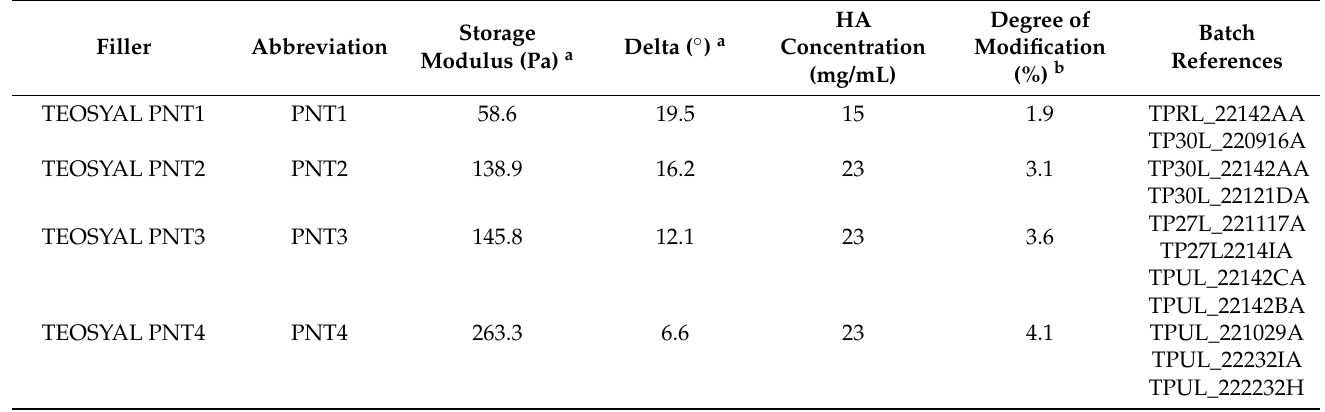
Table 1. List of the TEOSYAL fillers investigated in this